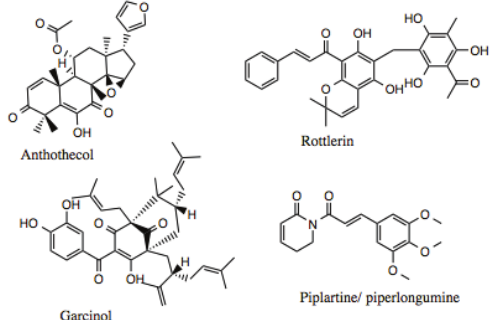
Figure 12. Structure of anthothecol, rottlerin garcinol and